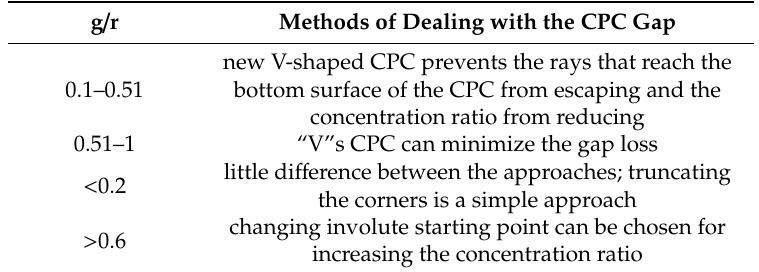
Table 2. The recommended methods of dealing with the CPC gap.